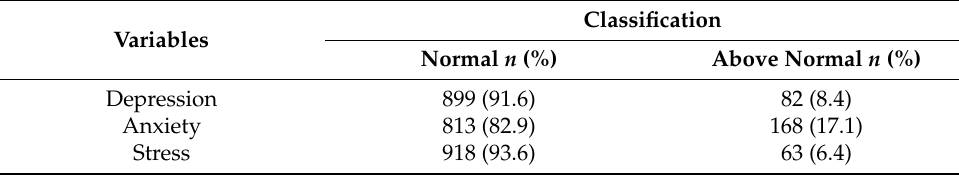
Table 2. Percentage of DAS by DASS-21 among respondents ( n =